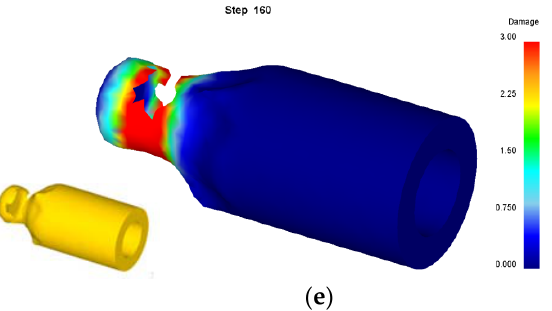
Figure 12. Damage value distribution of different friction coefficient between roller and billet. ( a ) 0.01; ( b ) 0.1; ( c ) 0.3; ( d ) 0.5; ( e ) 0.7.